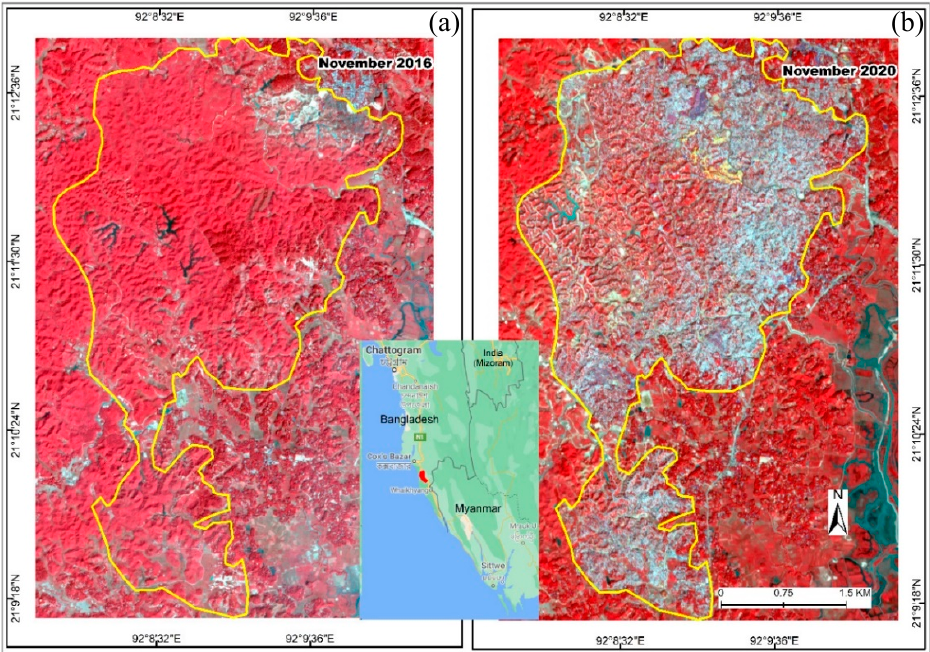
Figure 5. PlanetScope data of Kutupalong refugee campsite: ( a ) and ( b ) show the destruction of forest area due to the establishment of Rohingya refugee camps as observed from images taken on 25 November, 2016 and 15 November, 2020, respectively. [Source: prepared by authors].